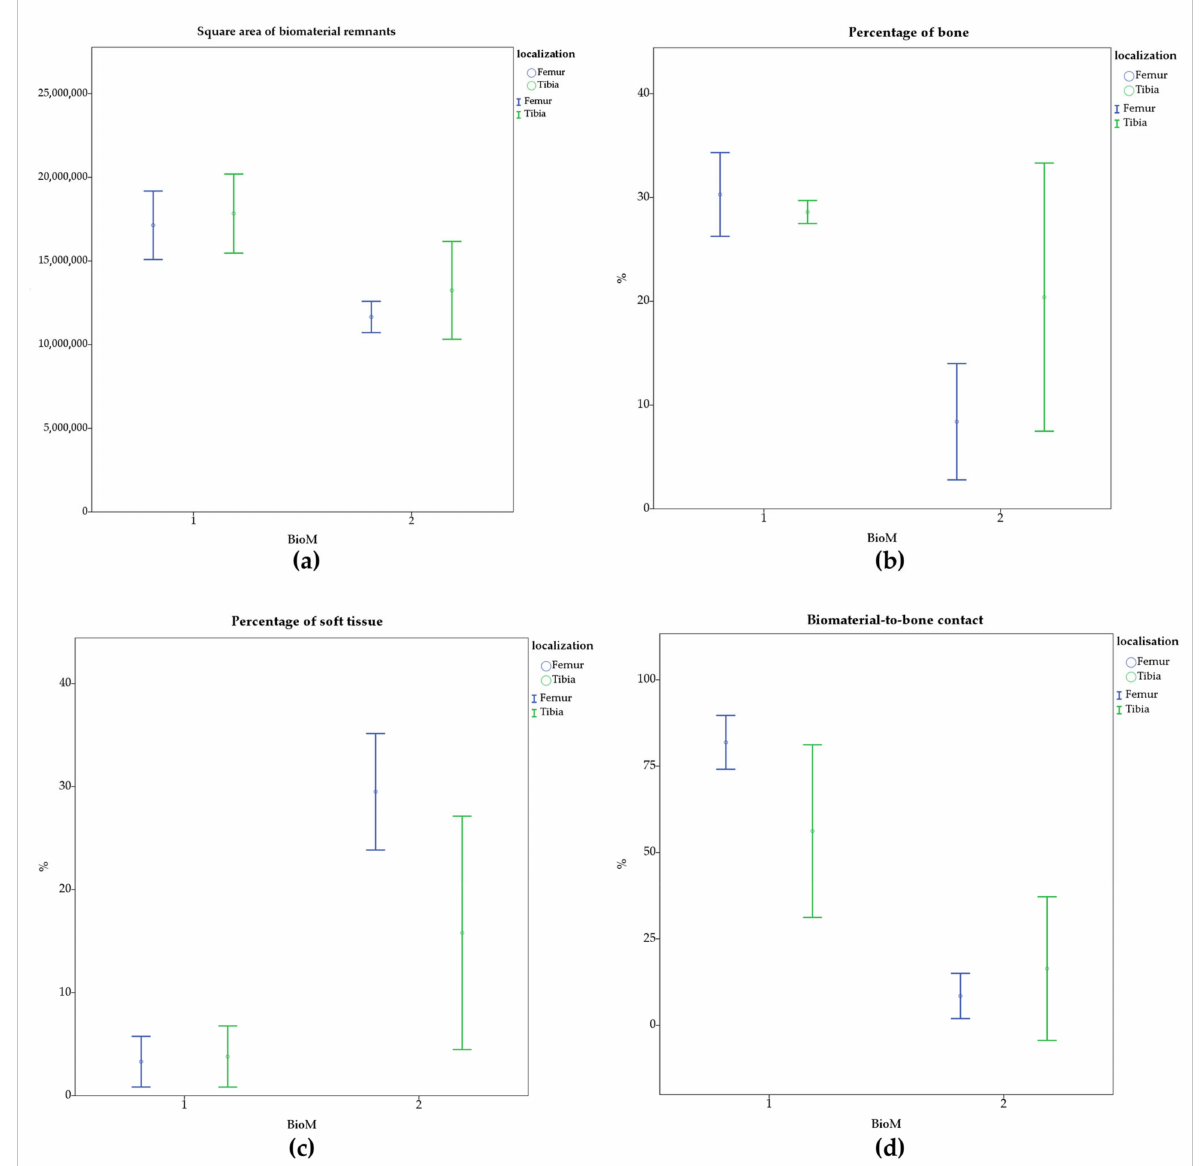
Figure 1. Histological evaluation after implantation of BioM1 and BioM2 in the femur and tibia of sheep for 12 months: ( a ) square area of the biomaterial remnants; ( b ) percentage of bone in the ROI; ( c ) percentage of soft tissue in the ROI; ( d ) bone-to-implant contact at the biomaterial to tissue